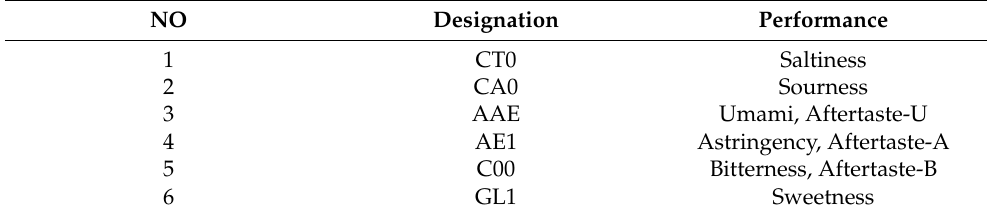
Table 2. E-tongue sensor performance